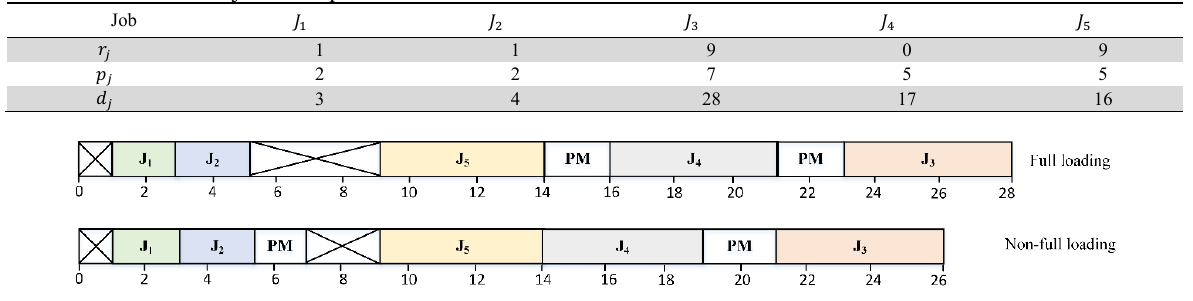
Basic information for 5 jobs example